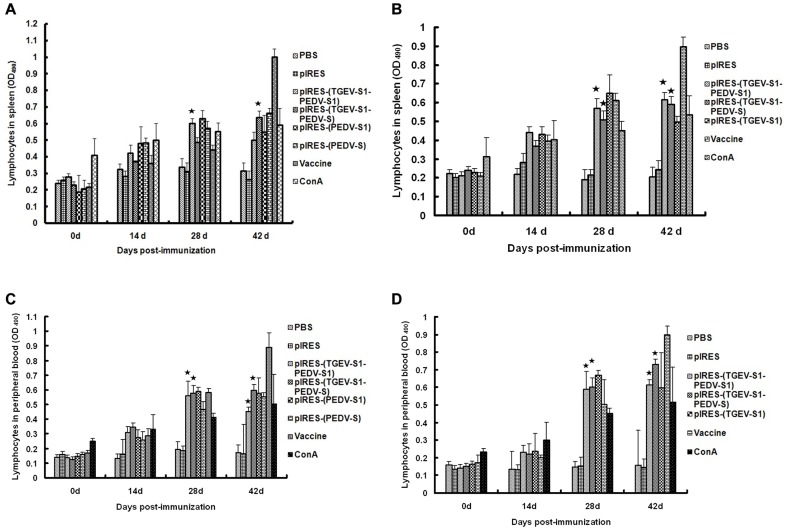
Changes in T lymphocyte numbers in the spleens and peripheral blood of immunized mice.The proliferation of T lymphocytes in mouse spleens (A and B) and peripheral blood (C and D) was analyzed by conventional MTT assays using recombinant PEDV-S1 (A and C), TGEV-S1 (B and D) protein and Con A as stimulating agents. The y-axis represents the lymphocyte proliferation index (OD490) in the spleen or peripheral blood. ★: p<0.01 (highly significant) compared with PBS group and pIRES group.